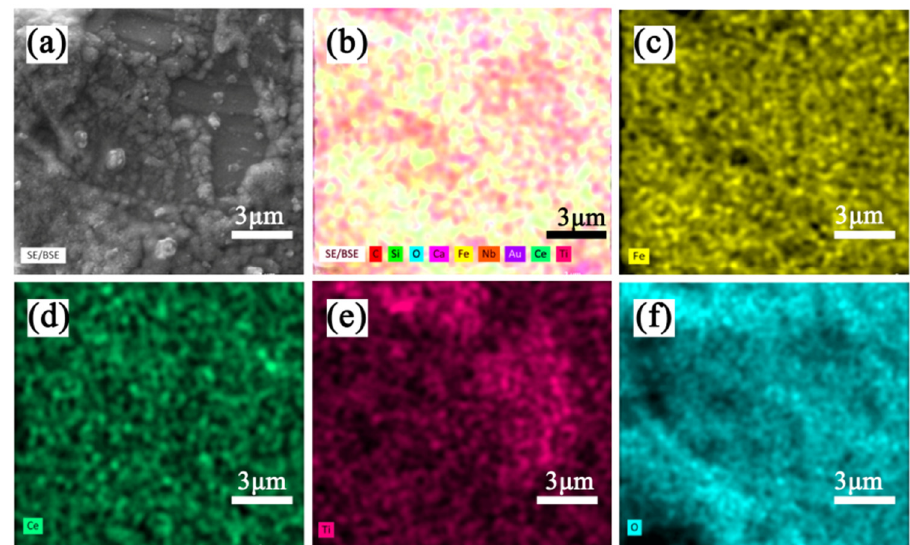
Figure 7: EDS mapping of tailings calcined at 600°C.